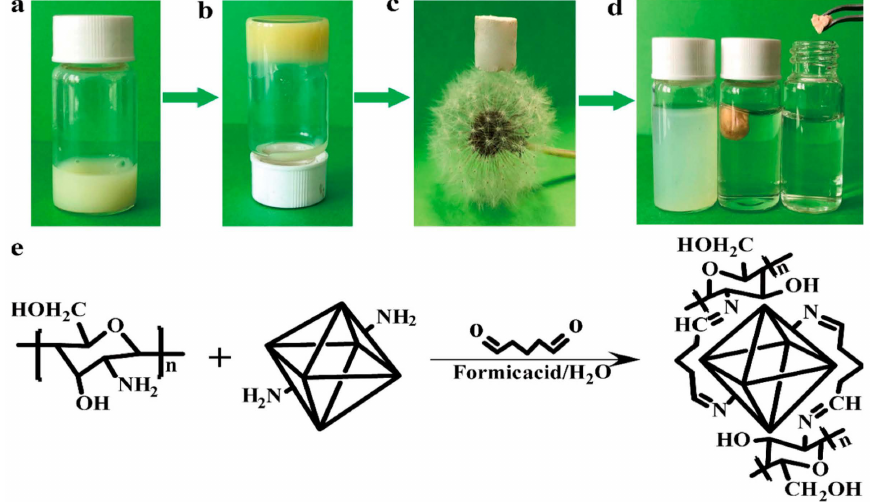
Figure 3. ( a – c ) Synthesis route of UiO-66-NH 2 -CS aerogel ( d ) Adsorption of Pb 2+ by UiO-66-NH 2 -CS ( e ) Synthesis equation of UiO-66-NH 2 -CS. Reprinted with permission from Ref. [83]. Copyright 2019,